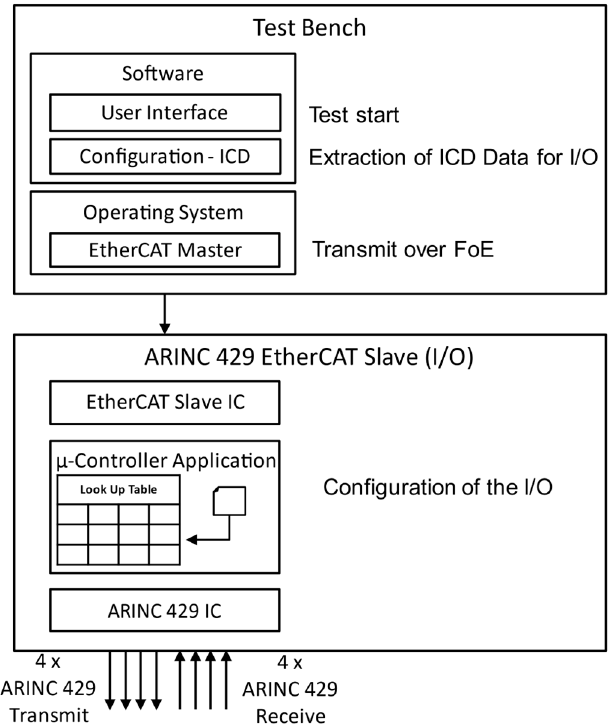
Figure 10. Configuration of the I/O with the ICD data.